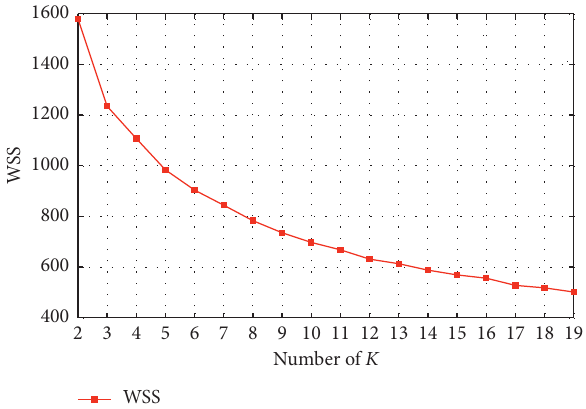
Figure 4: The WSS curve in determining the number of